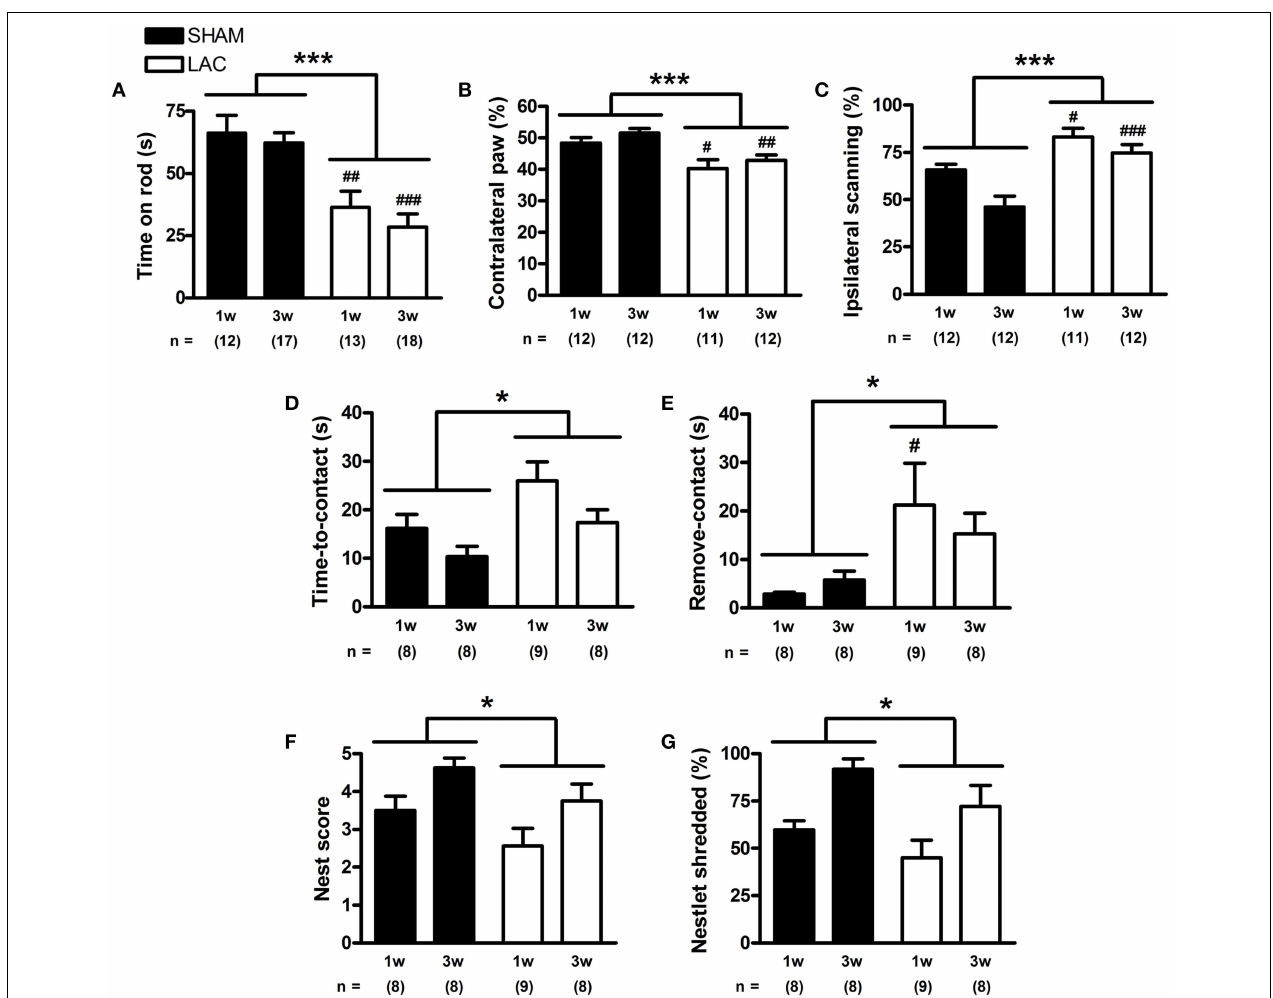
FIGURE 4 | Motor and somatosensory impairment in mice receiving 3 µ g LAC. In the accelerating rotarod test, LAC lesioned mice showed decreased time spent on the rod, compared to sham mice receiving vehicle (A) . In the cylinder test, LAC-treated mice engaged in significantly less right paw wall-contacts compared to sham mice (B) . Also, LAC-treated mice had an increased preference to scan the cylinder walls more with their intact ipsilateral side (C) . In the adhesive removal test, both time-to-contact ( D ), and the time required to remove the adhesive